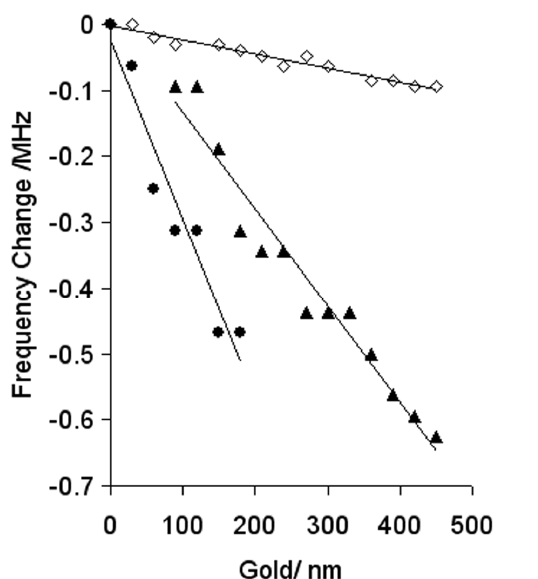
Figure 2. Relationship between mass loading and frequency of a SSBW device (open diamonds), and Love wave devices having guiding layers 1.12 μ m thick (closed triangles) and 2.24 μ m (closed circles).